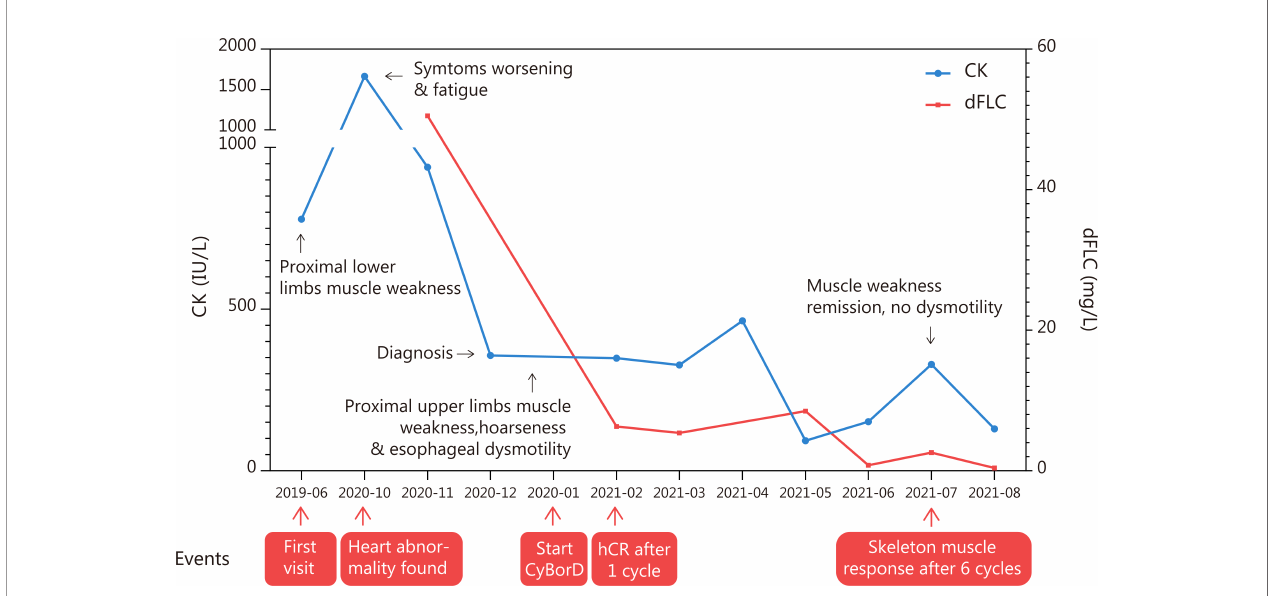
FIGURE 2 | Time and events of the case report. The level of creatine kinase considerably dropped after the initiation of CyBorD regime chemotherapy and is within the normal range at present. Hematological remission was also achieved soon after chemotherapy. Clinical symptoms were alleviated after six cycles of